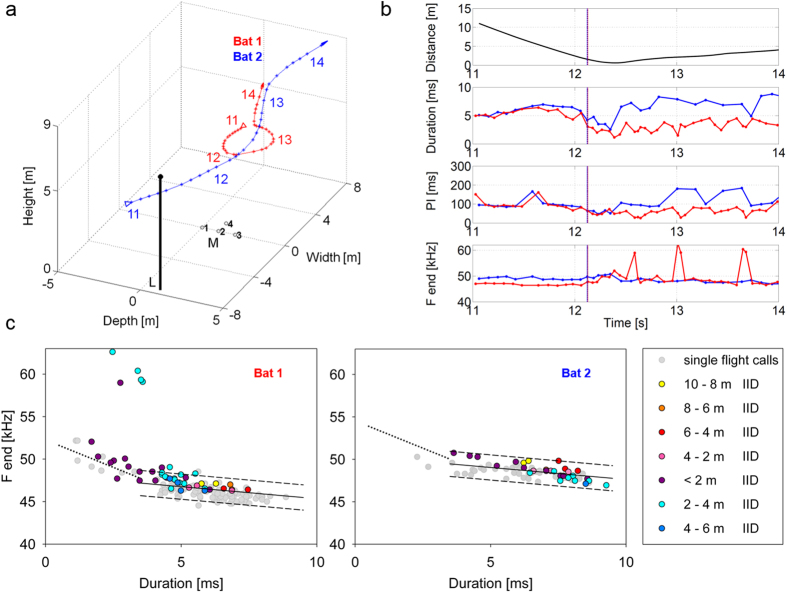
(a) 3D plot of the flight paths. Open arrows indicate the start and filled arrows the end of the flight path. Time (in seconds) is marked by numbers. L = street light, M = microphone array. (b) Inter-individual distance and call parameters of Bat 1 and Bat 2. The dotted vertical lines mark the beginning of the bats’ reaction in echolocation behavior. (c) Correlation of terminal frequency with call duration of Bat 1 and Bat 2 from signals emitted in single flight (grey dots) and in flight with the conspecific (colored dots). The single flight signals were used to position the individual transmission channels (between dashed lines) at the 5.5 ms frequency values. The color of the dots indicates groups of inter-individual distances (IID). During the encounter the two bats reacted to each other at a rather short distance (1.5 m) by a distinct reduction in sound duration and pulse interval. During the pursuit the leading Bat 2 switched back to normal search behavior with long sound durations and pulse intervals whereas the pursuer (Bat 1) continued its reaction as indicated by signals with short durations and pulse intervals. During the flight with the conspecific, the frequency of nearly all signals of Bat 1 and of all signals of Bat 2 were within the predicted individual transmission channel. Bat 1 also emitted a few short and high frequency calls while reacting to Bat 2.